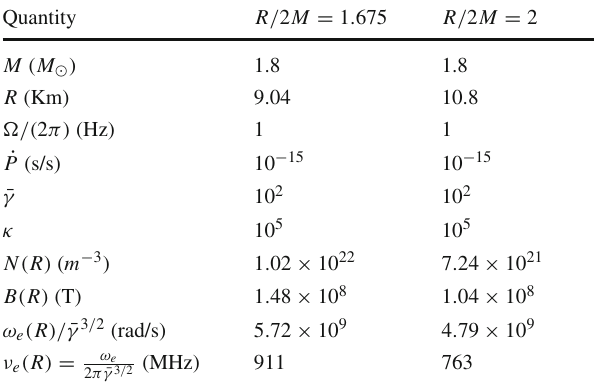
Table3 Characteristicvaluesoftheparametersinvolvedinthedescrip- tionoftheplasmamagnetosphereforaassumedmassof1.8solarmasses of the NS